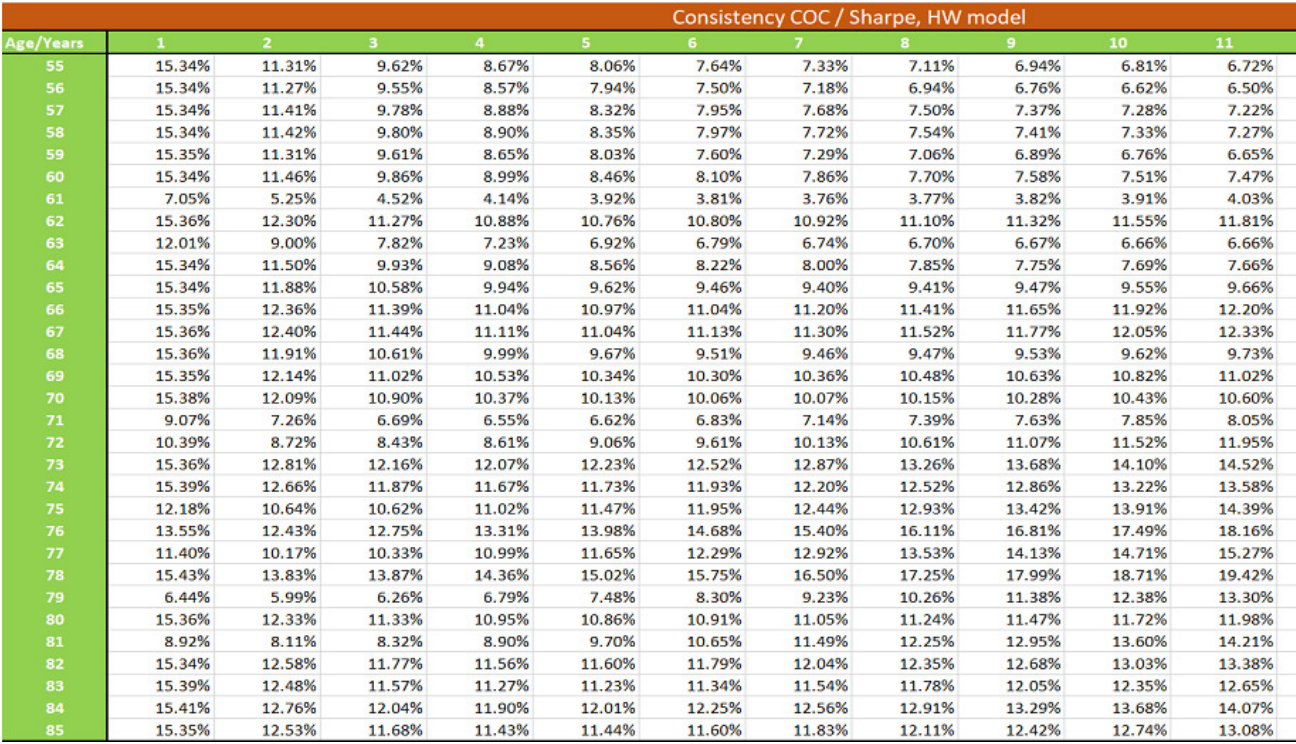
Figure A3. Consistency between Sharpe and Cost of Capital method, HW